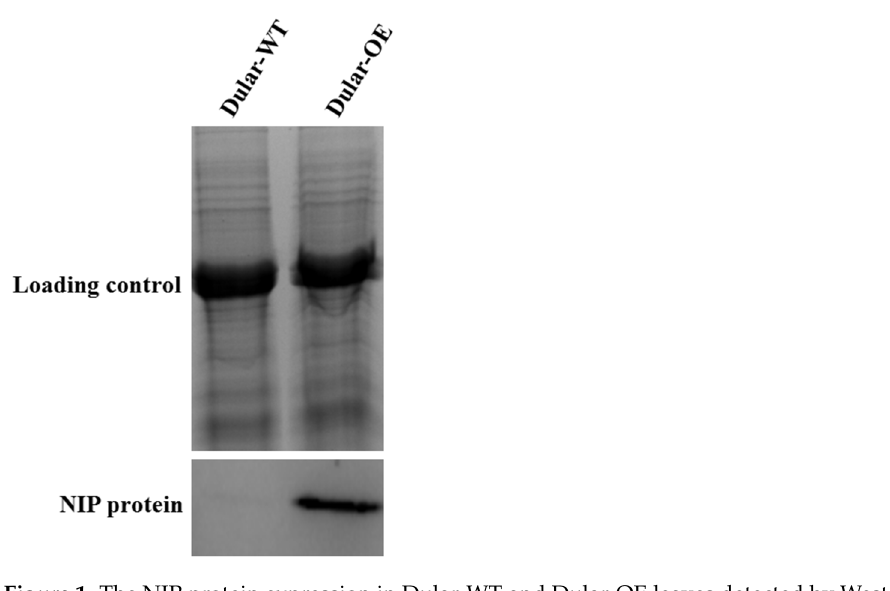
Figure 1. The NIP protein expression in Dular-WT and Dular-OE leaves detected by Western